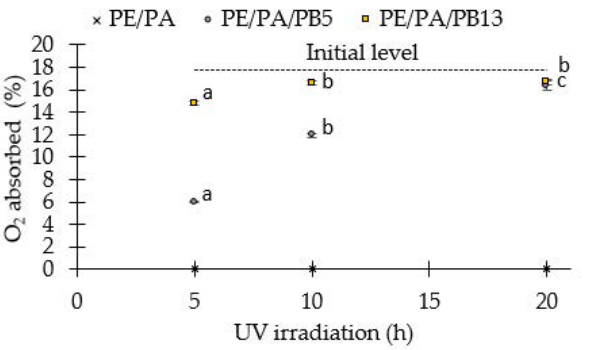
Figure 3. O 2 absorbed (%) by PE/PA, PE/PA/PB5 and PE/PA/PB13 films after UV radiation for 5, 10 and 20 h (mean ± SD, n = 3). Different superscripts within the same formulation indicate statistically significant different values ( p <